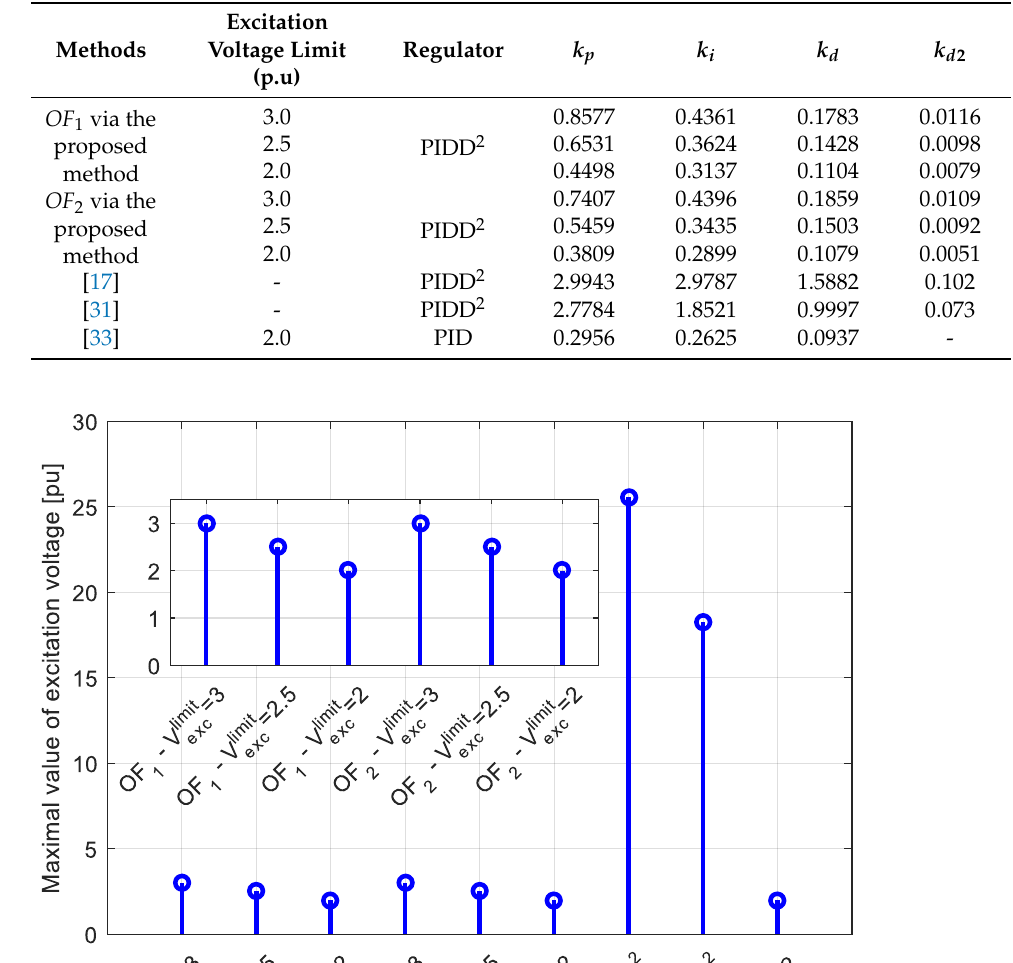
Figure 11. Comparison of the results in terms of the rise time obtained using different methods.